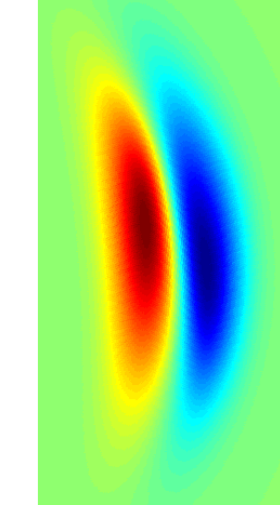
Fig. 2. Sample Wavelets